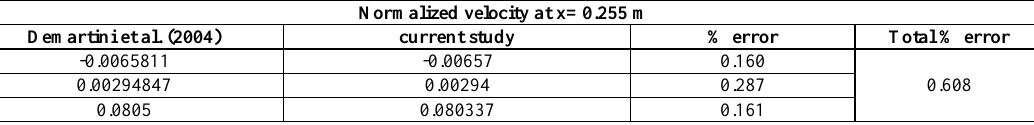
Table 1. % Error of Demartini et al. (2004) vs current